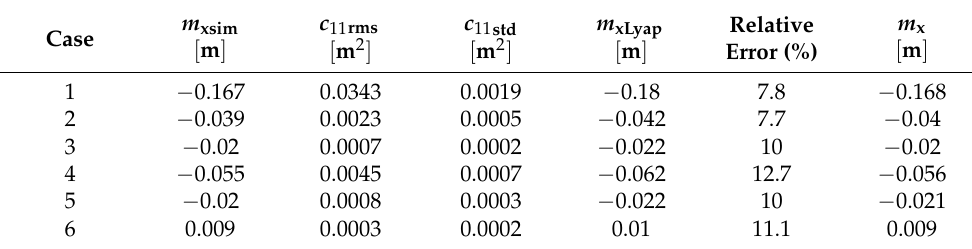
Table 6. The mean values and relative errors for relative